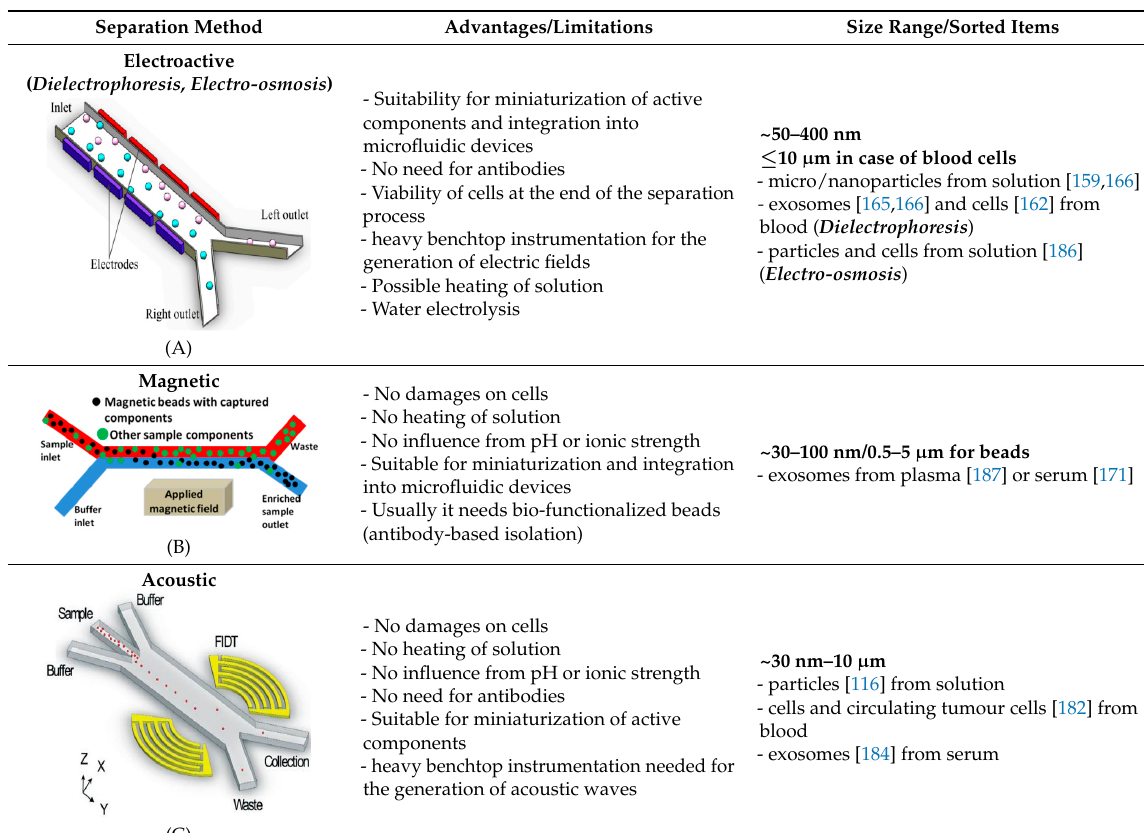
Table 4. Summary of active methods to isolate EVs, with schemes of working of the main techniques. ( A ) Scheme of dielectrophoretic separation of particles reproduced from reference [185]; ( B ) Magnetic separation of captured analytes; and, ( C ) Sorting scheme for Surface acoustic waves separation of particles, reproduced with permission from reference [181].